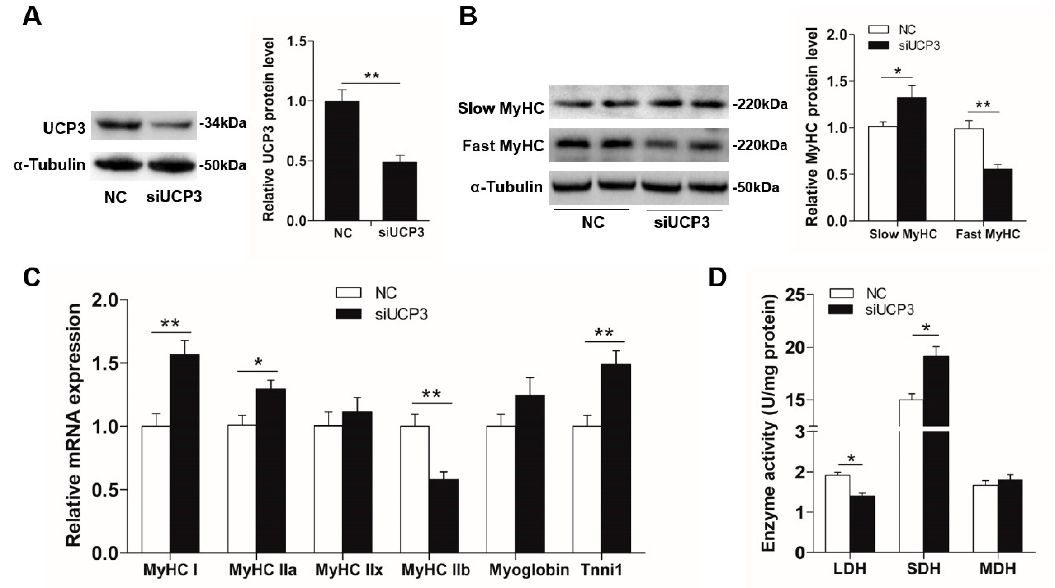
Figure 6. UCP3 promotes slow-to-fast myofiber type transformation. Transfection of siUCP3 into porcine myotubes knocked down UCP3 expression in protein ( A ) levels, which led to slow-twitch myofiber formation ( B ) as determined by immunoblotting. ( C ) MyHC isoforms and oxidative fiber markers in porcine myotubes transfected with siUCP3 were determined by RT-PCR. ( D ) The activities of metabolic-related enzymes in porcine myotubes transfected with siUCP3. Results are exhibited as mean ± S.E.M. ( n = 4, four independent experiments). * p < 0.05 and ** p < 0.01 when contrasted with the control.